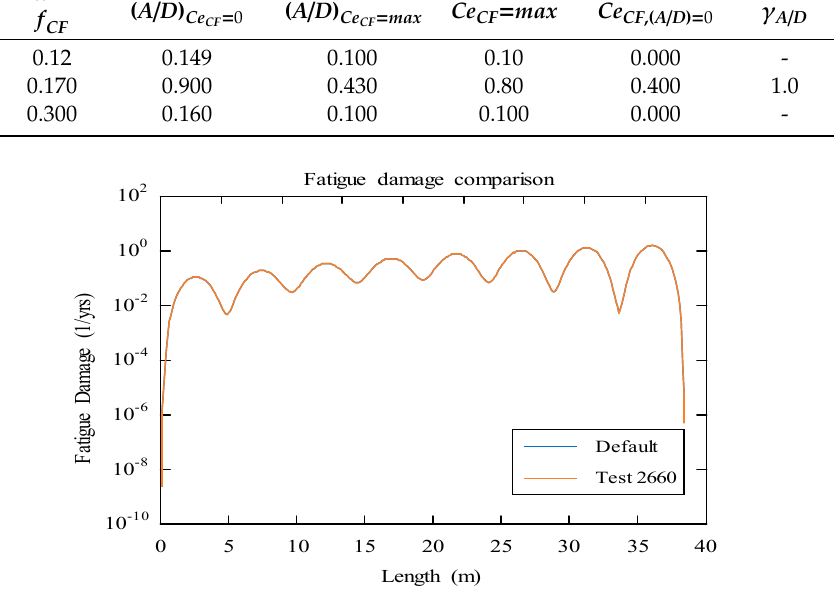
Figure 4. Comparison of the predicted fatigue damage between parameter set no. 2660 and default parameters. The results using the default parameters overlap with the results using parameter set no. 2660. Table 5. Predicted responses for the default set of parameters and parameter with set no. 2660. Set No.